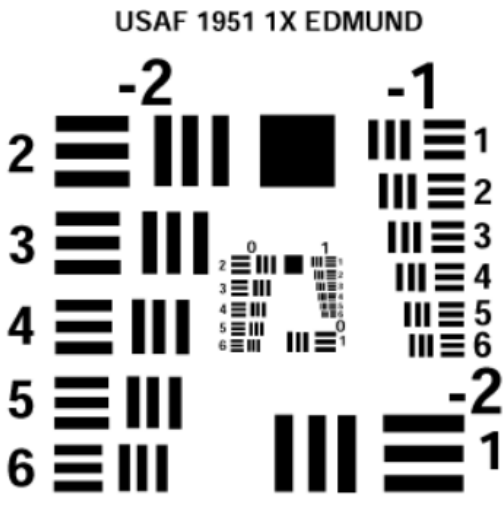
Figure 2. USAF 1951 Test Pattern (Messina, 2006)